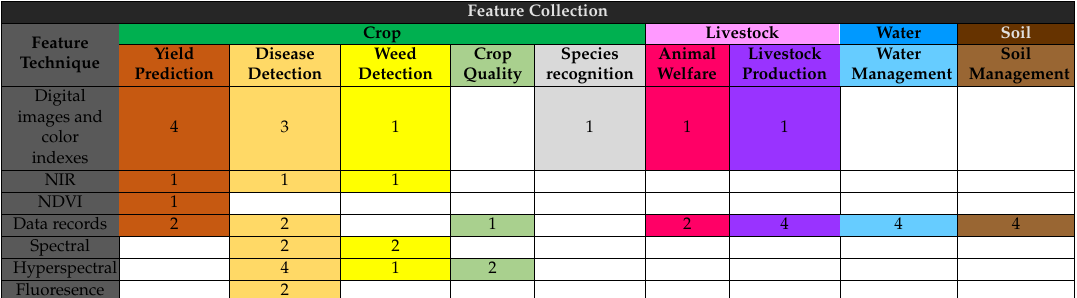
Figure 5. Data resources usage according to each sub ‐ category. NDVI—normalized difference vegetation index; NIR—near infrared. Table 15. Data resources usage according to each sub ‐ category.